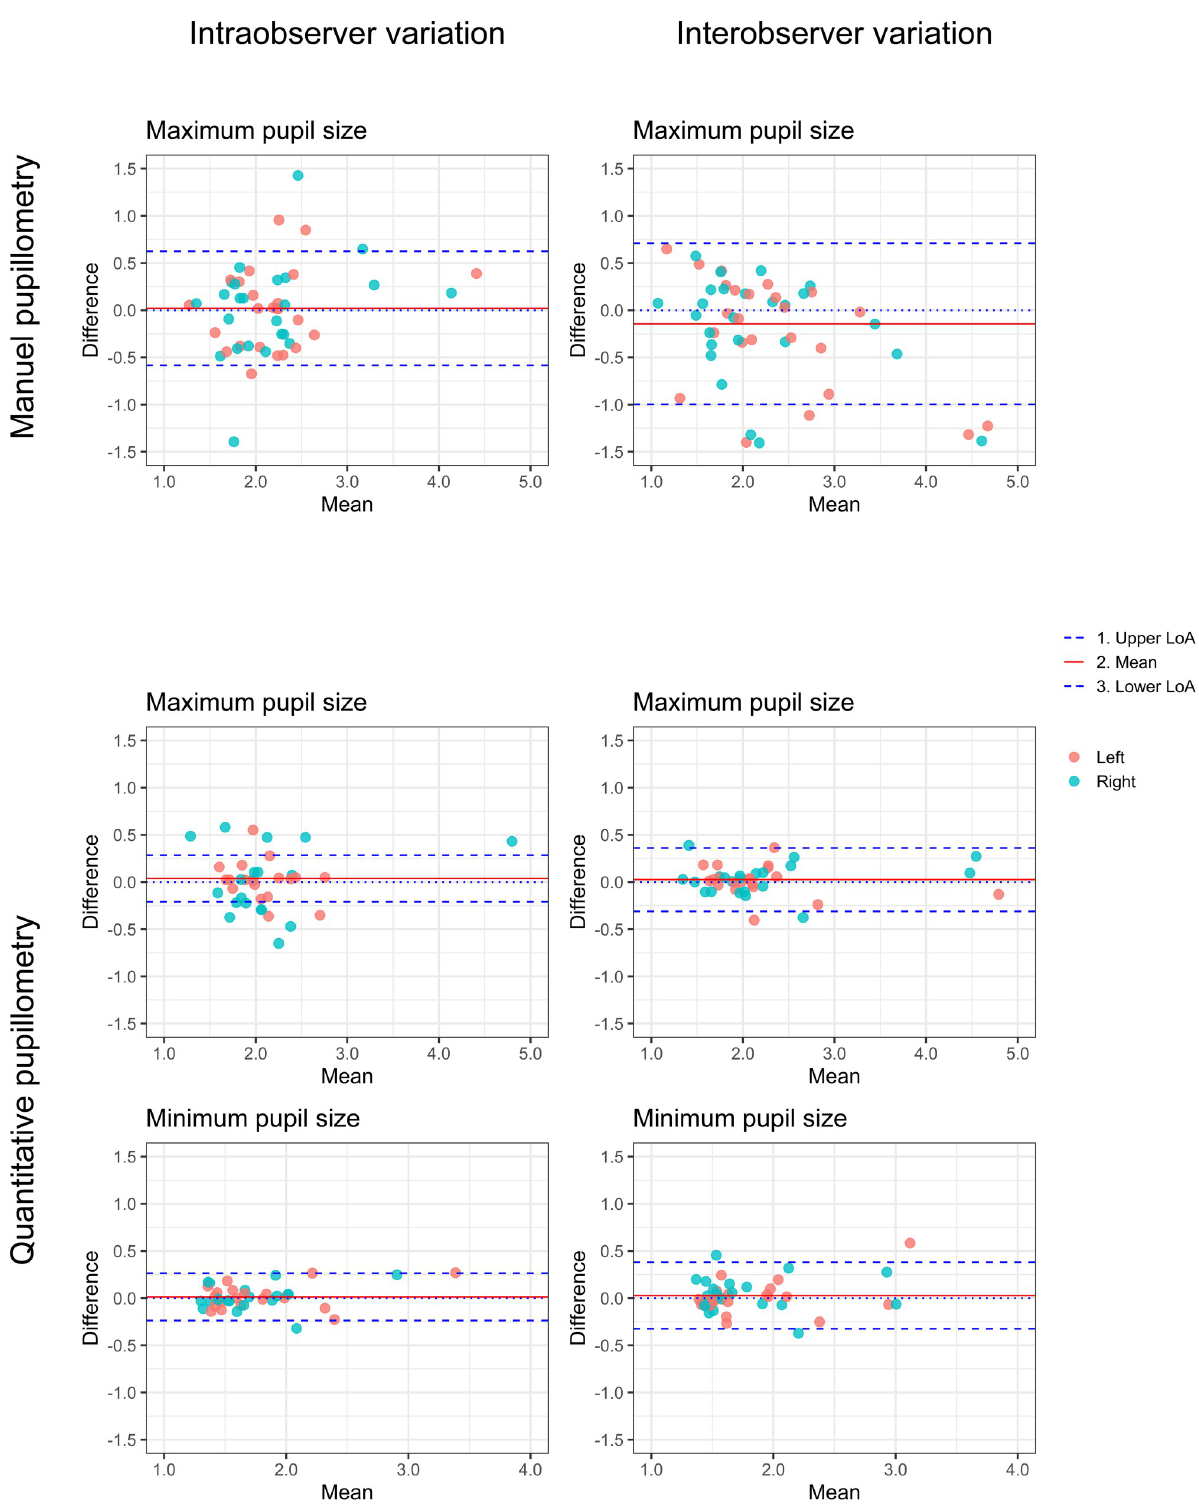
Fig 2. Standard manual versus quantitative pupillometry—Pupil size. Bland Altman plots depicting intra-, and inter-observer variability of pupil size measured with manual and quantitative pupillometry.